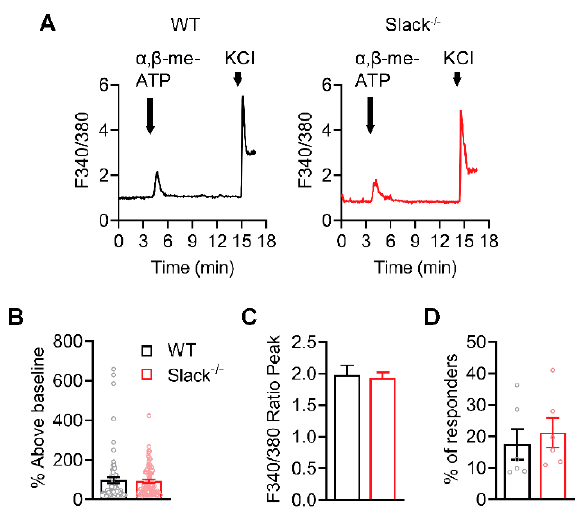
Figure 6. P2X3-mediated Ca 2+ traces are normal in sensory neurons of Slack -/- mice. ( A ) Representative examples of Fura-2 ratiometric Ca 2+ traces in DRG neurons of WT and Slack -/- mice evoked by α , β -meATP (30 µM, 30 s application) and KCl (75 mM, 20 s application). Responses to KCl were used to test neuron viability. Experiments were performed in lumbar (L4-L5) DRG neurons ( n = 402–518 neurons per group). ( B , C ) Quantification of the magnitude of the Ca 2+ response to α , β -meATP stimulation with percentage above baseline (( B ) p = 0.7858) and ratio peak (( C ) p = 0.7858). ( D ) Quantification of the percentage of responsive neurons to α , β -meATP stimulation ( p = 0.5966). The data show that α , β -meATP-evoked Ca 2+ responses are similar in DRG neurons from Slack -/- and WT mice. Bars denote mean ± SEM and circles show data from each neuron in ( B ) and from each mouse in ( D ). Student’s t-tests were performed.